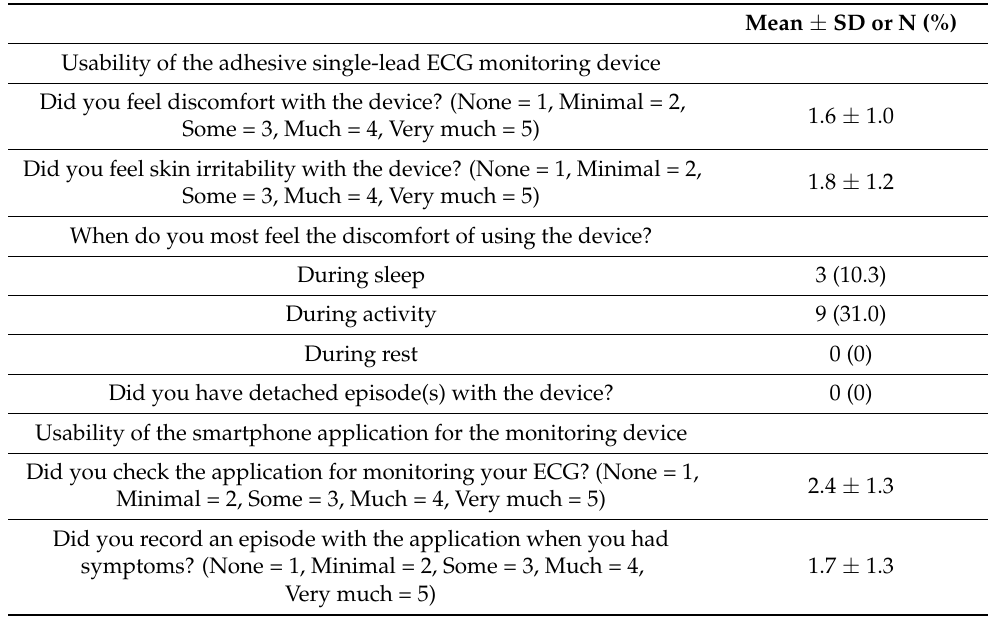
Table 5. The self-reported questionnaire on using the MC-100 (English-translated version).